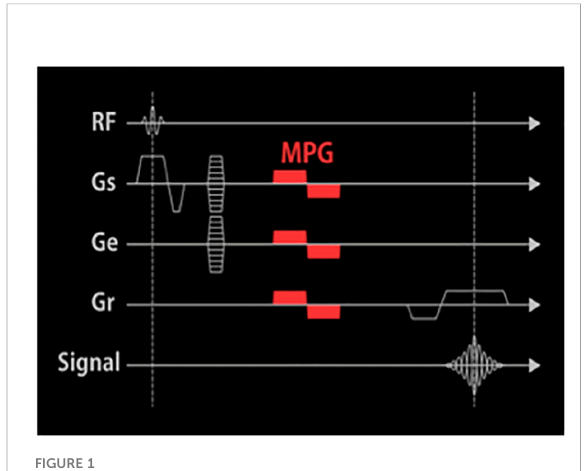
FIGURE 1 The pulse sequence diagram of CE-T 1 WI FSBB. An MPG pulse is applied at the end of the excitation RF pulse and the front of the Gro in three directions: Gss, Gpe, and